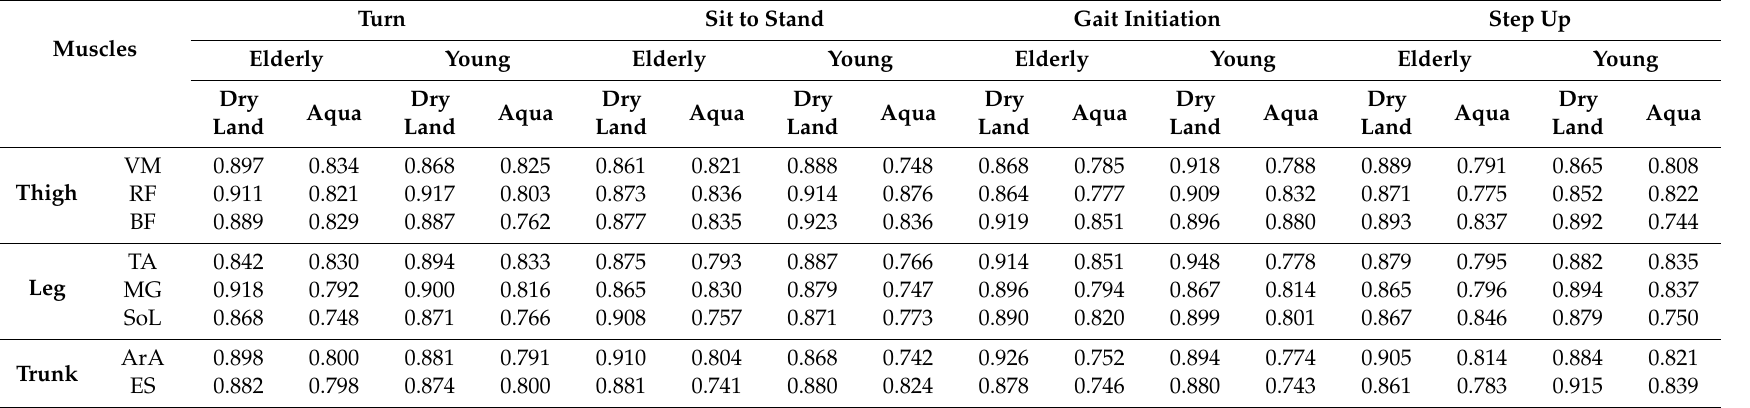
Table 2. Stability of EMG records both in dry and in an aquatic environment for both groups (elders and